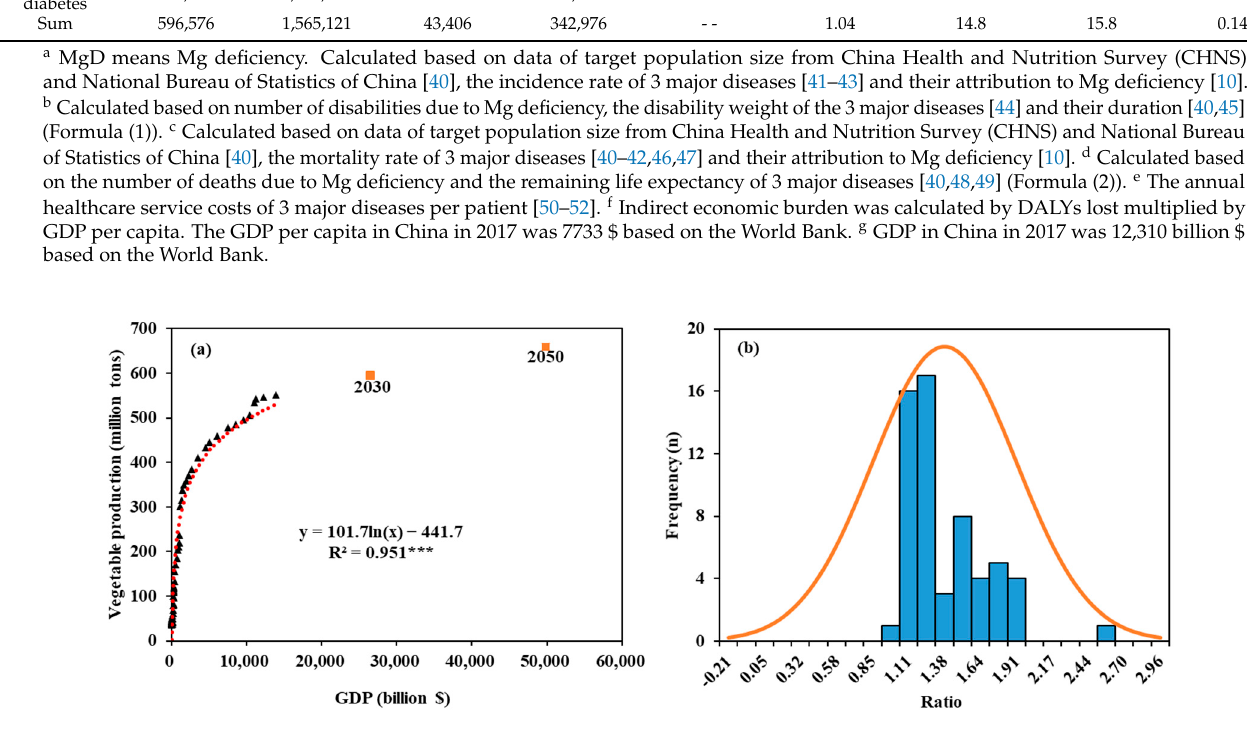
Figure 3. The relationship between gross domestic product (GDP) and vegetable production ( a ) and the improvement ratio of vegetable Mg content by Mg biofortification ( b ). The black triangles represent values from 1960–2018, the orange square represent predicted values in year 2030 and 2050. The predicted GDP of China in 2030 and 2050 are 26,499 and 49,853 billion dollars, respectively [53]. The median value of vegetable Mg content improvement ratio by Mg biofortification was 1.22 based on meta-analysis (Formula (3)). *** indicates significant difference at p <